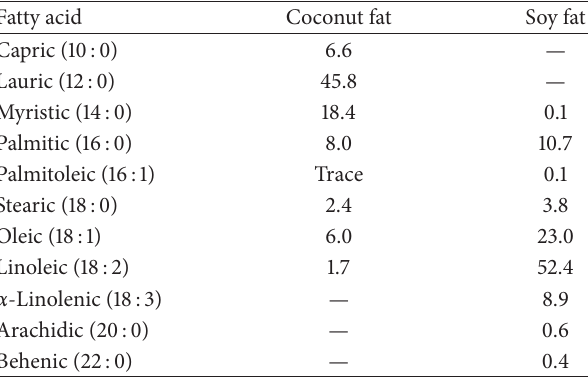
Table 4: Fatty acid composition of study